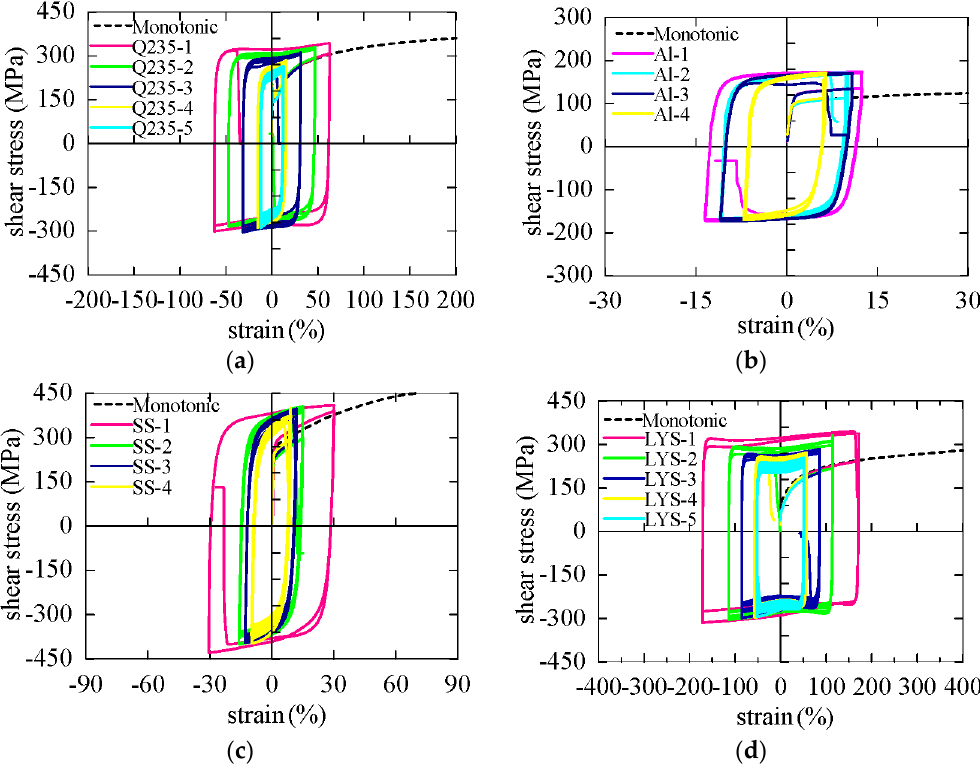
Figure 12. Hysteretic curves of the test specimens. ( a ) Q235; ( b ) AL6061; ( c ) SS316; ( d ) LYS160.